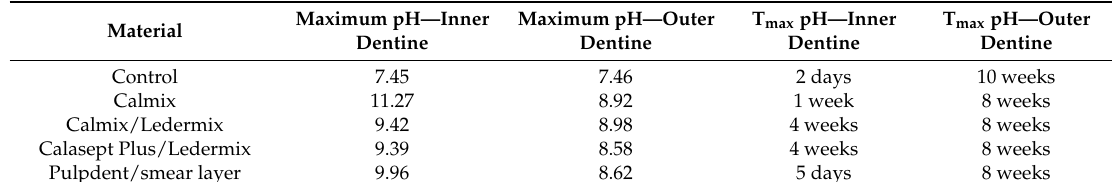
Table 1. Maximum pH values obtained and the time taken to reach maximum pH (T max ) in the different levels of dentine.